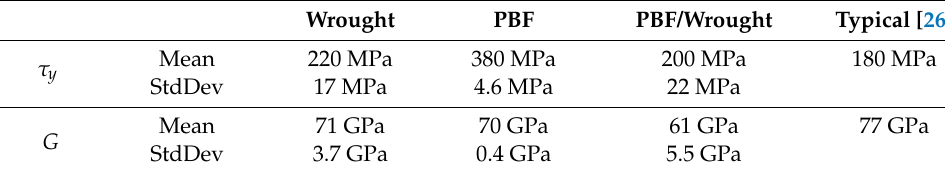
Figure 6. Average torsion test stress/rotation.